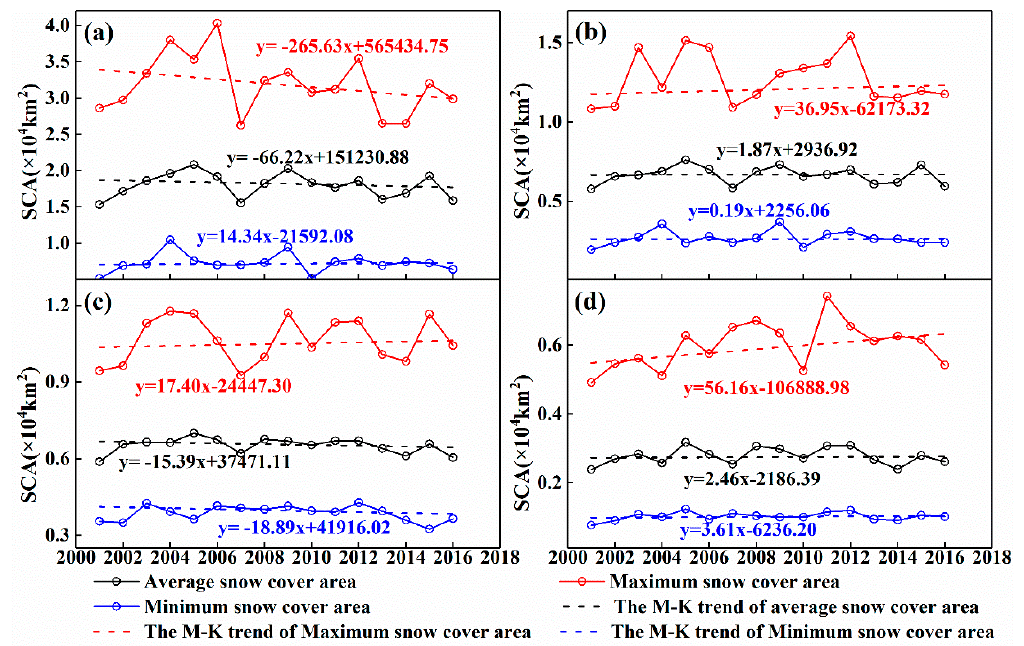
Figure 7. Snow cover area (SCA) changes (average, maximum, and minimum) in the ( a ) YRK, ( b ) KRK, ( c ) YUK, and ( d ) KRY in 2001–2016.